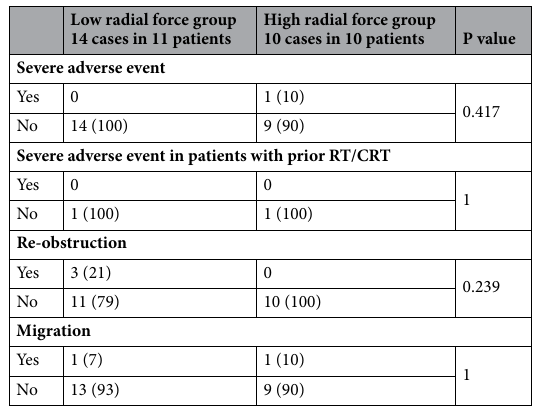
Table 6. Outcome of patients with adenocarcinoma of the esophagogastric junction. Data are presented as n (%). These data were compared using Fisher’s exact